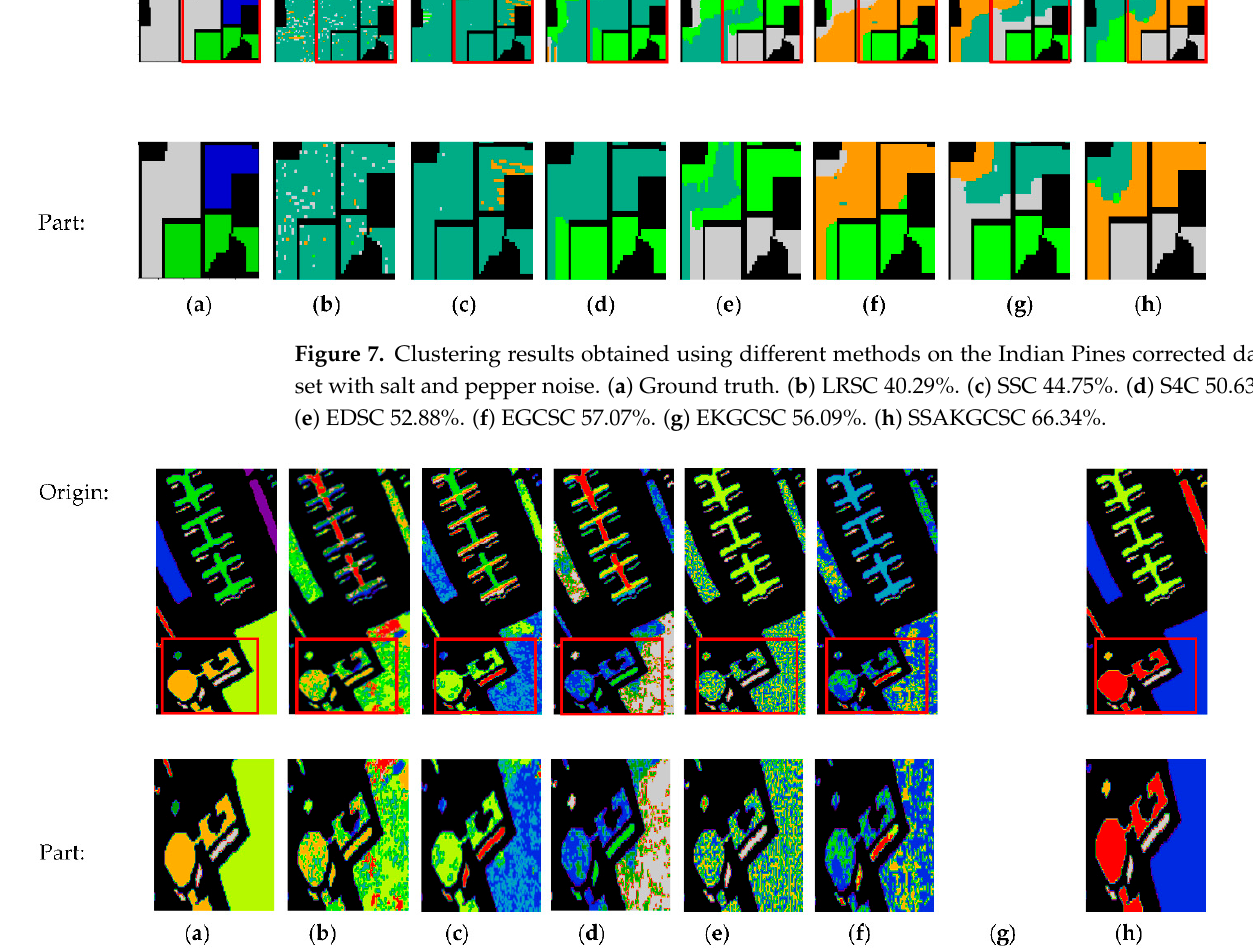
Figure 8. Clustering results obtained using different methods on the Pavia University data set with salt and pepper noise. ( a ) Ground truth. ( b ) LRSC 37.69%. ( c ) SSC 51.22%. ( d ) S4C 53.31%. ( e ) EDSC 53.56%. ( f ) EGCSC 60.12%. ( g ) EKGCSC. ( h ) SSAKGCSC 79.83%.